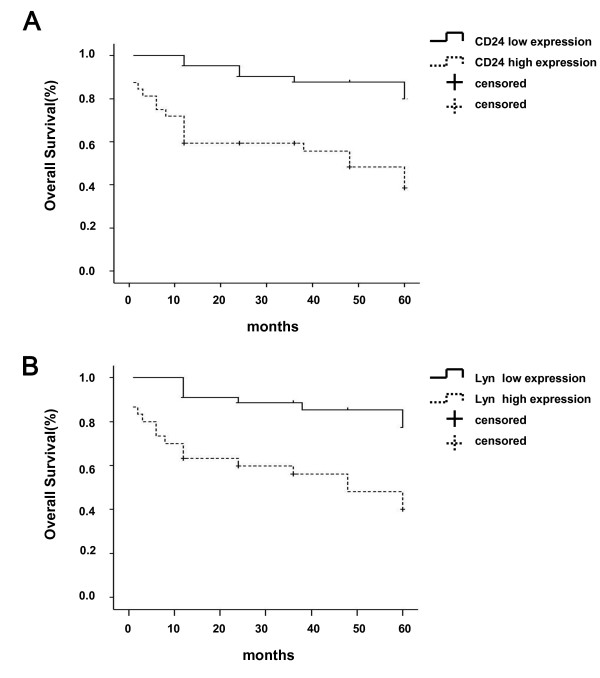
Kaplan-Meier survival curves of 74 CRC patients relating to the status of CD24 (A) and Lyn (B) expression. The log-rank test was used to calculate P values (CD24: P = 0.020).